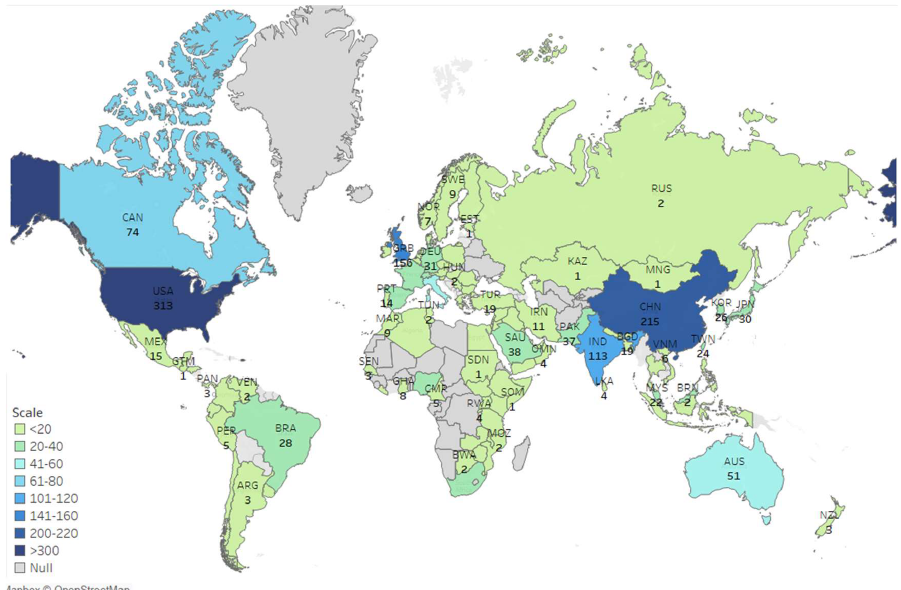
Figure 1. County–Specific productions (based on the Scopus